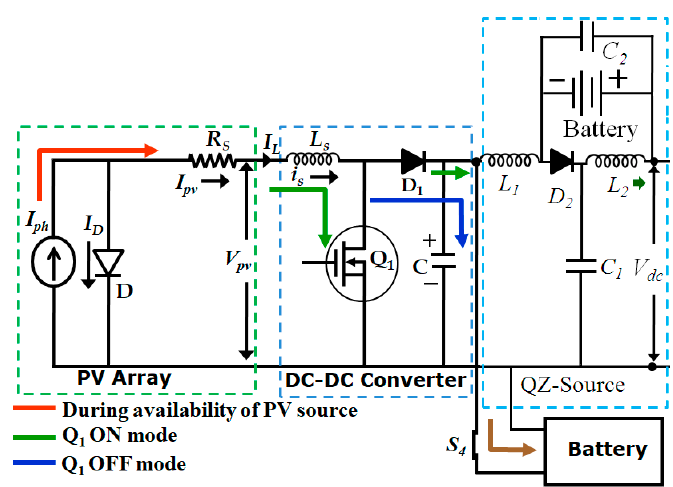
Figure 2. Current flow diagram for the mode of generation of solar photovoltaic power.